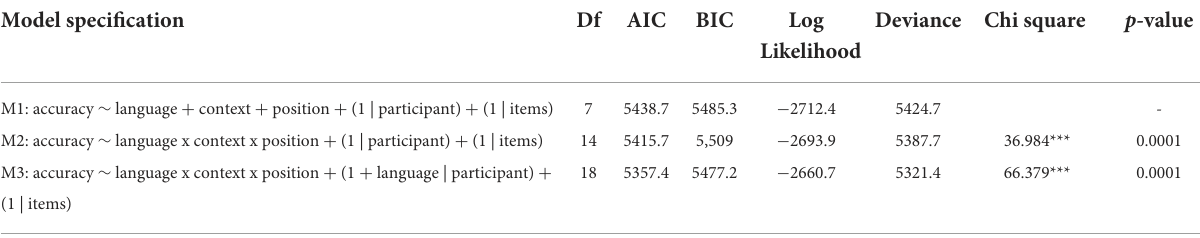
TABLE 1 Goodness-of-fit comparison between the three tested GLME models. Model specification